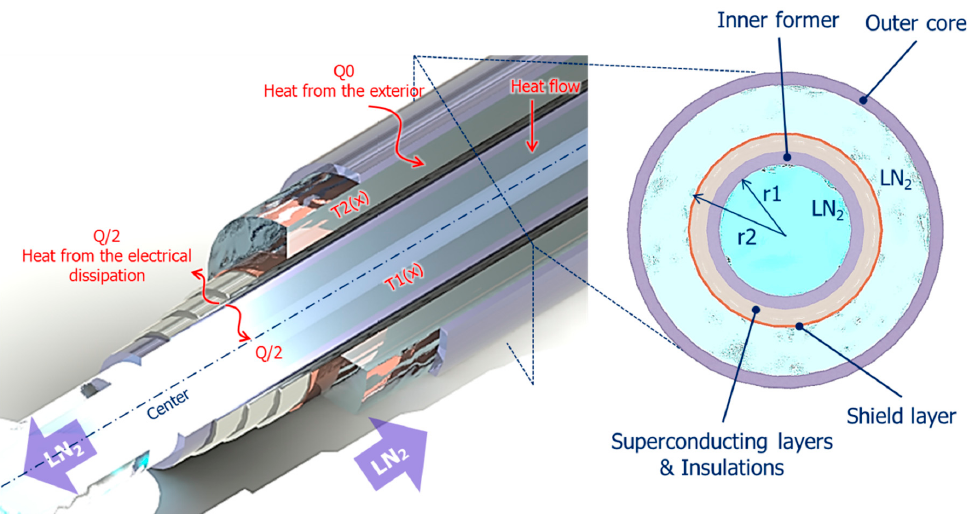
Figure 3. Modeling of the thermal analysis of a three-phase coaxial HTS power cable.